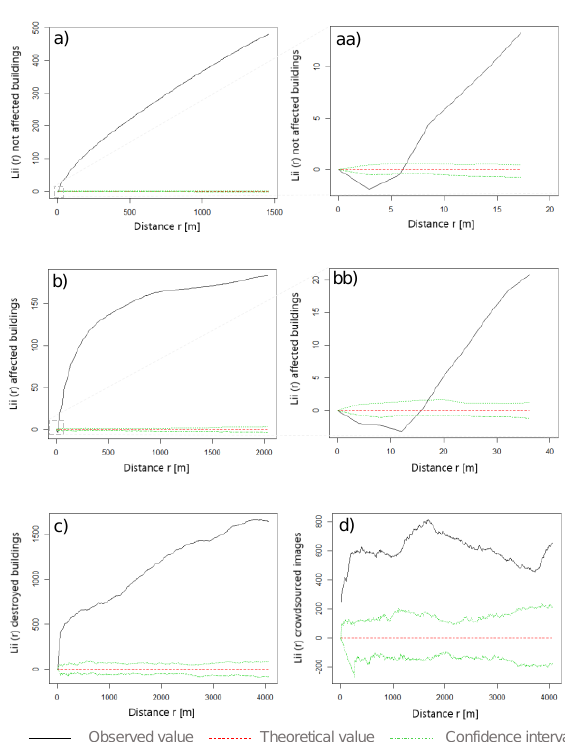
Figure 5. Self-function Lii for a) not affected buildings, aa) zoom on the distribution for small distances <20m, b) affected buildings, bb) zoom on the distribution for small distances <40m, c) destroyed buildings, d) crowdsourced